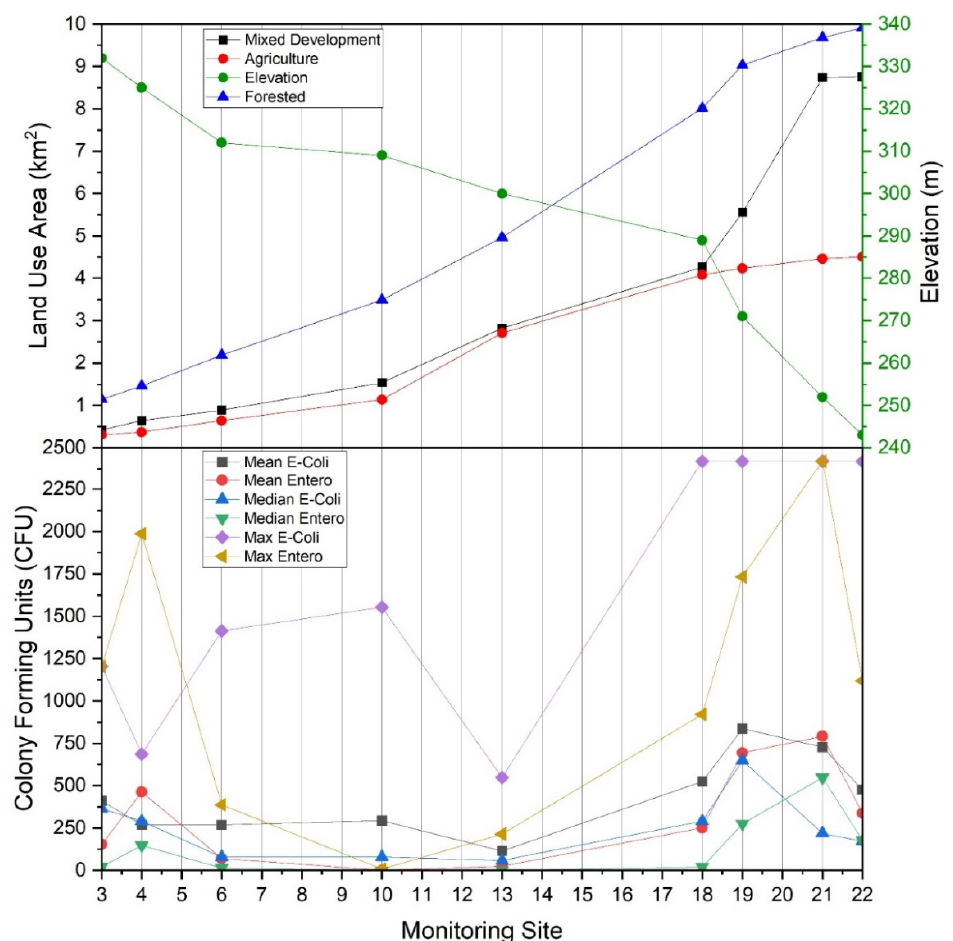
Figure 8. (Top) Land use type by area (km 2 ) draining to main stem West Run Creek monitoring sites #3, #4, #6, #10, #13, #18, #19, #21 and #22, and elevation (m) for each monitoring site, relative to (Bottom) average (mean), median and maximum Escherichia coli and enterococci concentrations (CFU per 100 mL) in West Run Watershed, Morgantown, WV, USA.